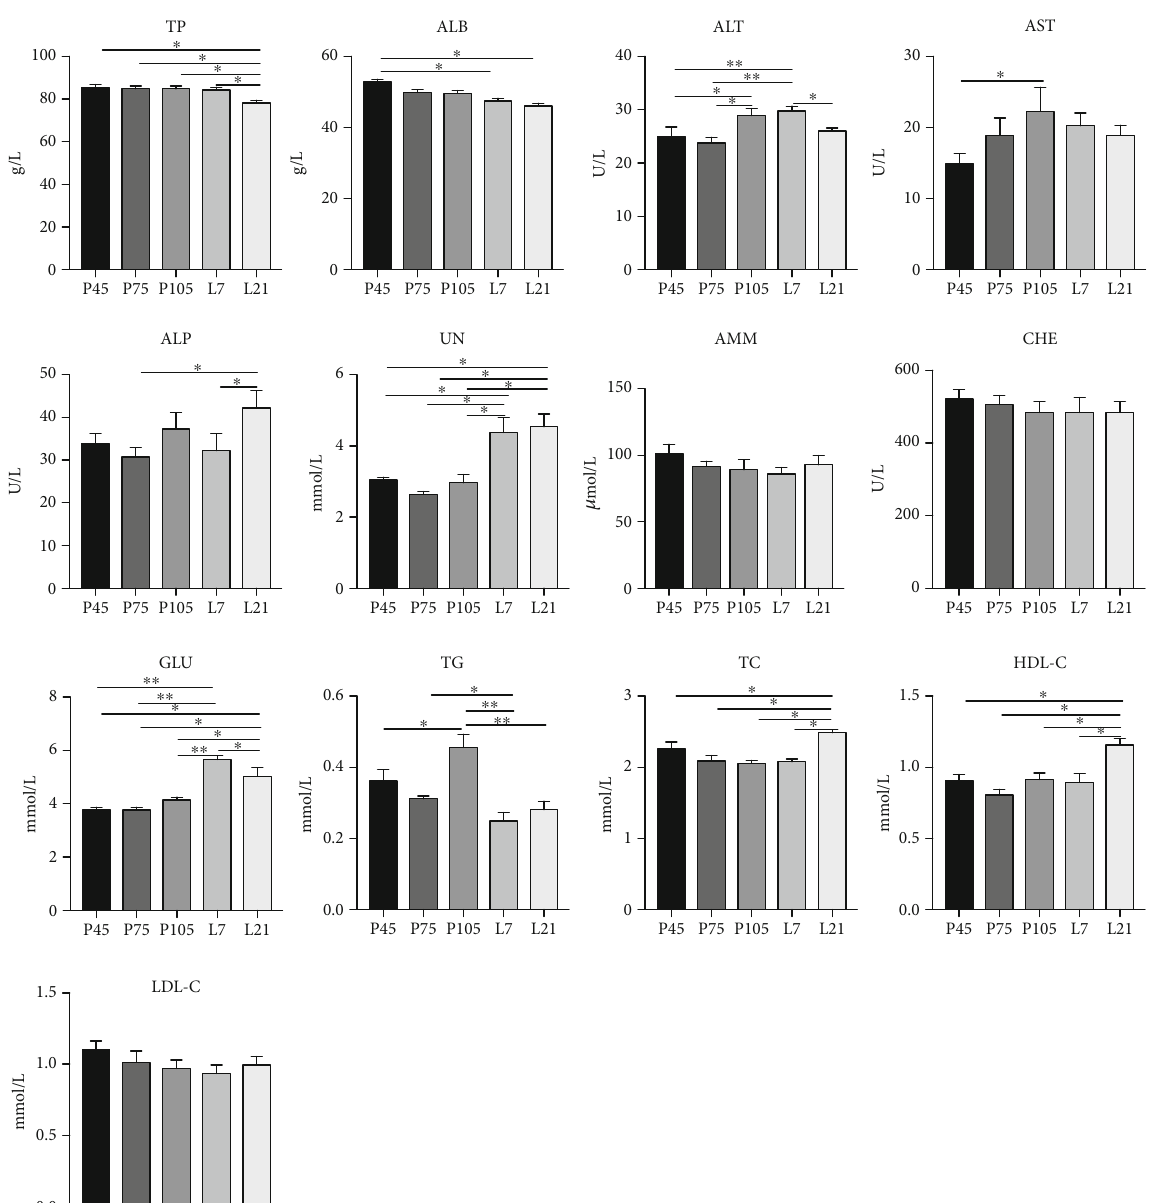
Figure 2: The changes of plasma biochemical parameters in sows at di ff erent stages of pregnancy and lactation. TP: total protein; ALB: albumin; ALT: alanine aminotransferase; AST: aspartate aminotransferase; ALP: alkaline phosphatase; UN: urea nitrogen; AMM: ammonia; CHE: cholinesterase; GLU: glucose; TG: triglyceride; TC: total cholesterol; HDL-C: high-density lipoprotein-cholesterol; LDL-C: low-density lipoprotein-cholesterol. L7 and L21 mean day 7 and day 21 of lactation, respectively. The same as below. Data show the means ± SEM . ∗ P < 0 : 05 , ∗∗ P < 0 : 01 . n = 6 ‐ 8 per